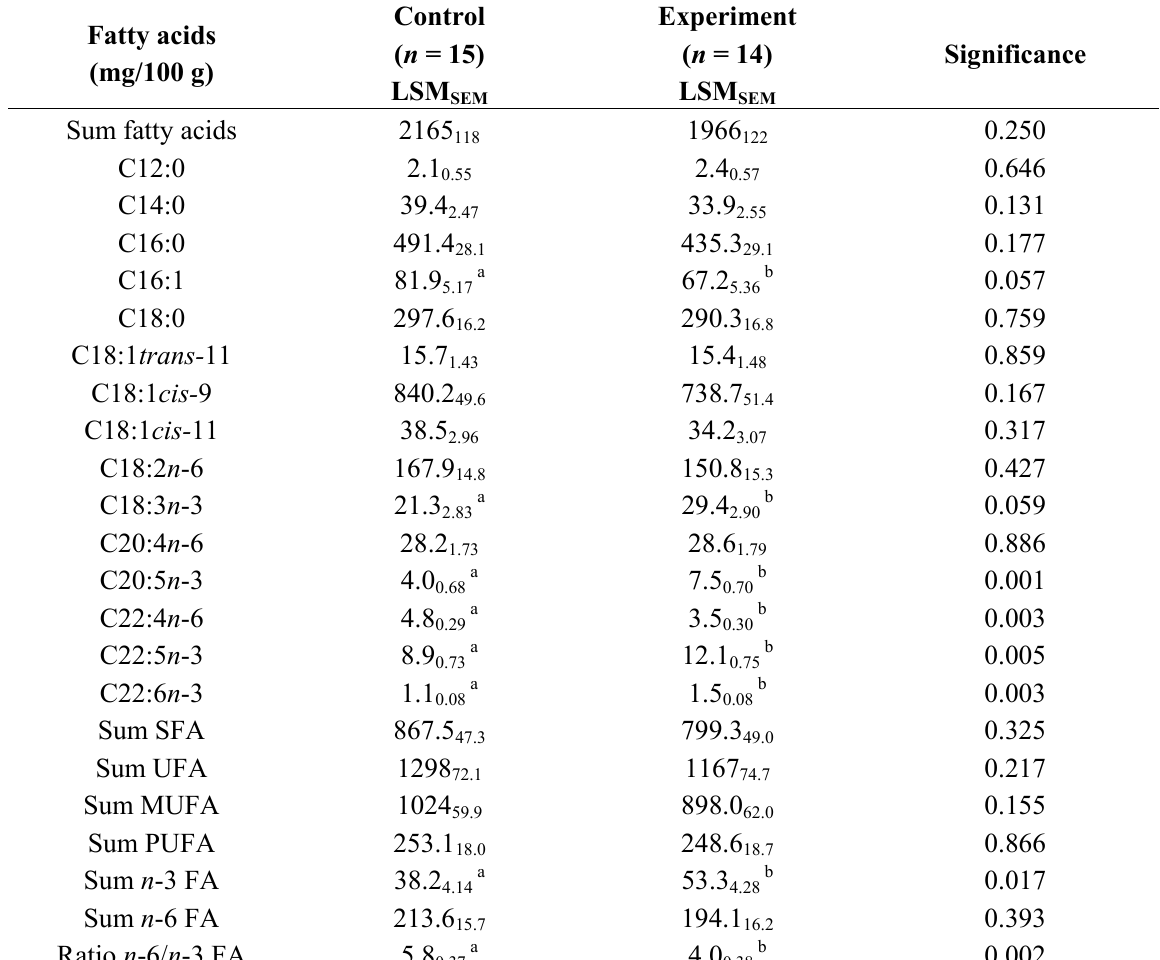
Table 2. Fatty acid concentration (mg/100 g) of corned beef produced from meat sections of German Holstein bulls fed a different